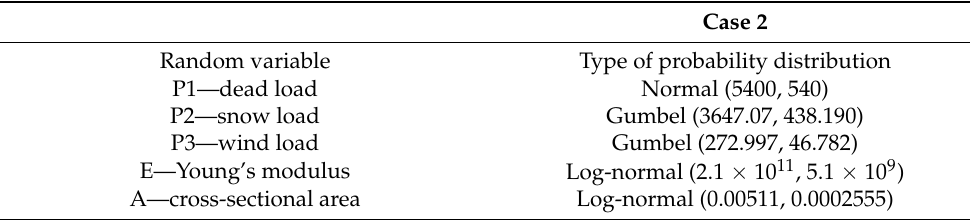
Table 4. Description of random variables for Case